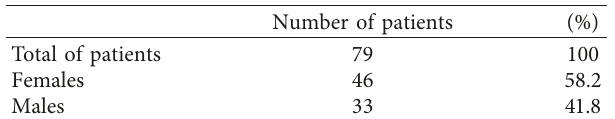
Number of patients